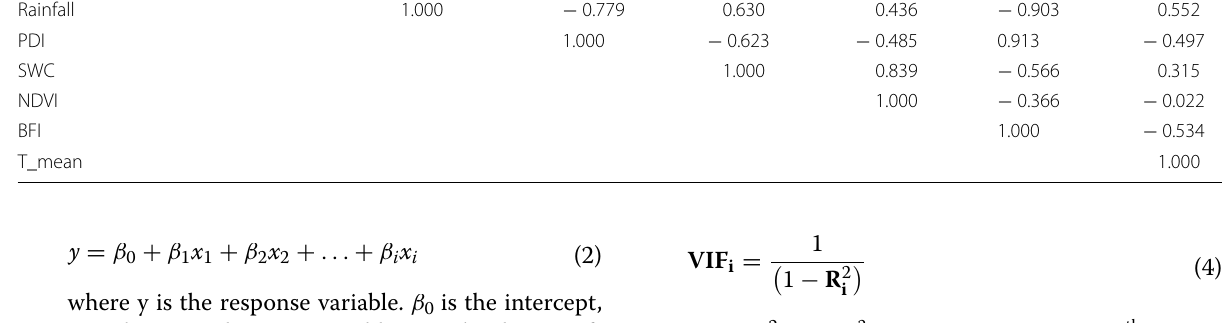
Table 2 Correlation coefficients of streamflow versus landscape-climate explanatory variables Streamflow Rainfall